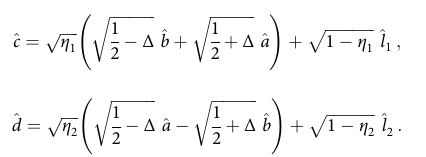
Fig. 5 Physical model of the QRNG showing the involved modes. The local oscillator described by the mode ^ b interferes with the vacuum state described by mode ^ a at a beam splitter with re fl ectivity 1 diode ef fi ciencies are modeled as beam splitters with transmittivities η 1 and η 2 , where the output modes from the central beam splitter are interfered with vacuum modes ^ l 1 and ^ l 2 . The difference of the two photo currents from photo diodes PD1 and PD2, each generated by the light described by conversion factor K , is ampli fi ed electronically by h amp , during which electronic noise is added to the output of the detector.